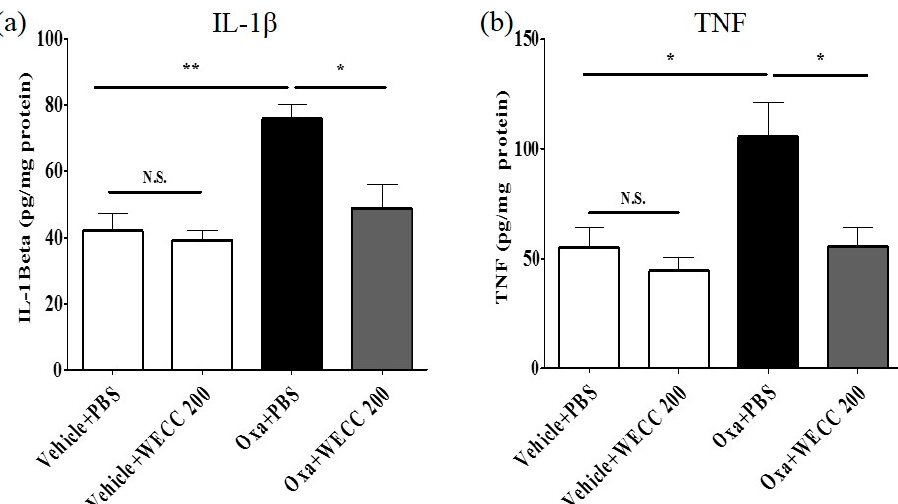
Figure 4. Inhibitory effect of WECC on spinal pro-inflammatory cytokines. Levels of IL-1 β ( a ) and TNF ( b ) in the spinal cord were measured with ELISA. Vehicle and oxaliplatin were administered intraperitoneally. PBS and 200 mg/kg of WECC were administered orally. n = 6 per group. Data are presented as mean ± SEM. N.S.: non-significant; * p < 0.05; ** p < 0.01 by one-way ANOVA followed by Bonferroni’s post-test.